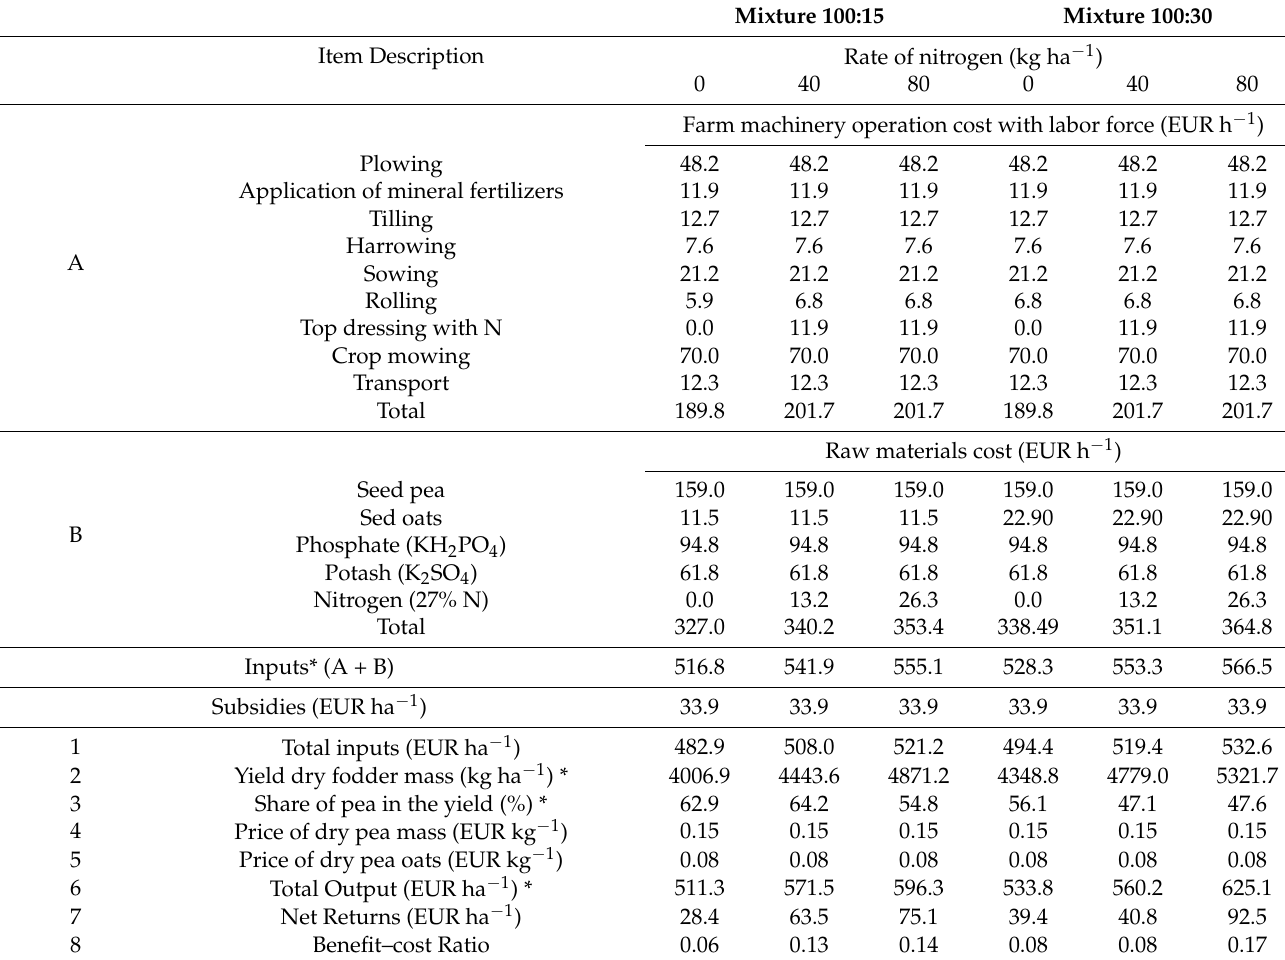
Table 6. Economic contributions of field pea and oats mixtures under various treatments with nitrogen. Mixture 100:15 Mixture